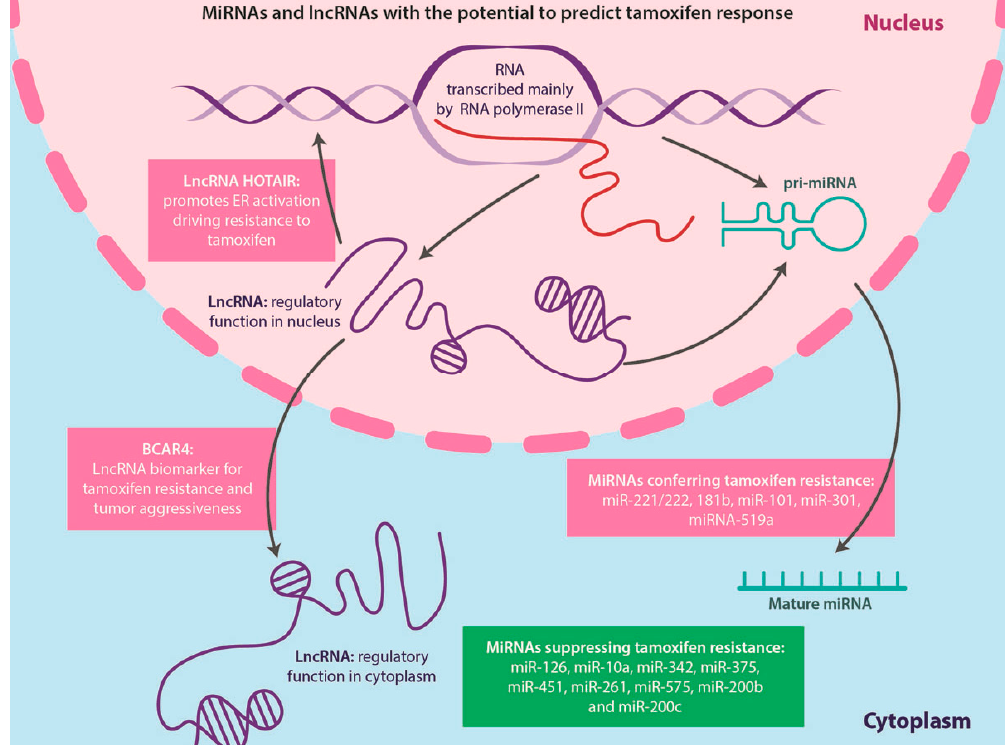
Figure 8. MicroRNAs (MiRNAs) and long non-coding RNAs (lncRNAs) with the potential to predict tamoxifen response. The majority of miRNA and lncRNAs are transcribed by RNA polymerase II. MiRNAs are frequently originating from introns of protein-coding transcripts but can also be processed from lncRNAs, via precursors called pri-miRNAs. In breast cancer, miRNAs have been suggested to be important for predicting tamoxifen response, since they can modulate the effects of anti-estrogen therapy. LncRNAs can function either in the nucleus or the cytoplasm and recent studies have demonstrated their role in endocrine resistance. For example, HOTAIR was shown to promote ER activation, driving resistance to tamoxifen and breast cancer anti-estrogen resistance 4 (BCAR4) was found to be a biomarker for tamoxifen resistance, with prognostic value for tumor